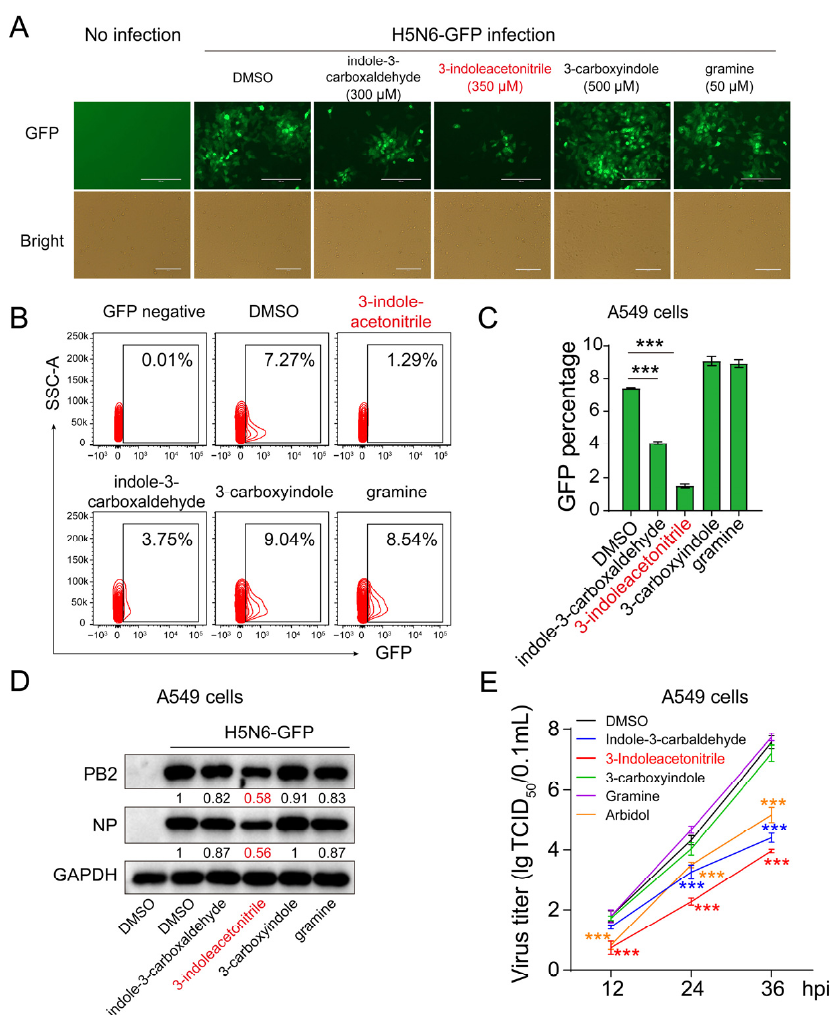
Figure 2. The effect of indole derivatives on H5N6-GFP virus replication. The A549 cells were infected with the H5N6-GFP virus at an MOI of 0.005, followed by treatment with 3-indoleacetonitrile, indole-3-carboxaldehyde, 3-carboxyindole, and gramine at indicated concentrations for 24 h. After that, the GFP intensity was acquired using fluorescence microscopy ( A ). The percentage of GFP-positive cells was calculated through flow cytometry ( B , a presentative image) ( C , data collected from three independent biological experiments). The viral PB2 and NP proteins were analyzed by Western blotting ( D ). The growth curves of H5N6-GFP virus in supernatants were determined based on three time points of infection as indicated ( E ), 3-indoleacetonitrile (350 µ M); indole-3-carboxaldehyde (300 µ M); 3-carboxyindole (500 µ M); gramine (50 µ M); arbidol (8 µ M). *** p < 0.001; calculated from three independent experiments by two-tailed Student’s t -test ( C ) or two-way ANOVA ( E ).